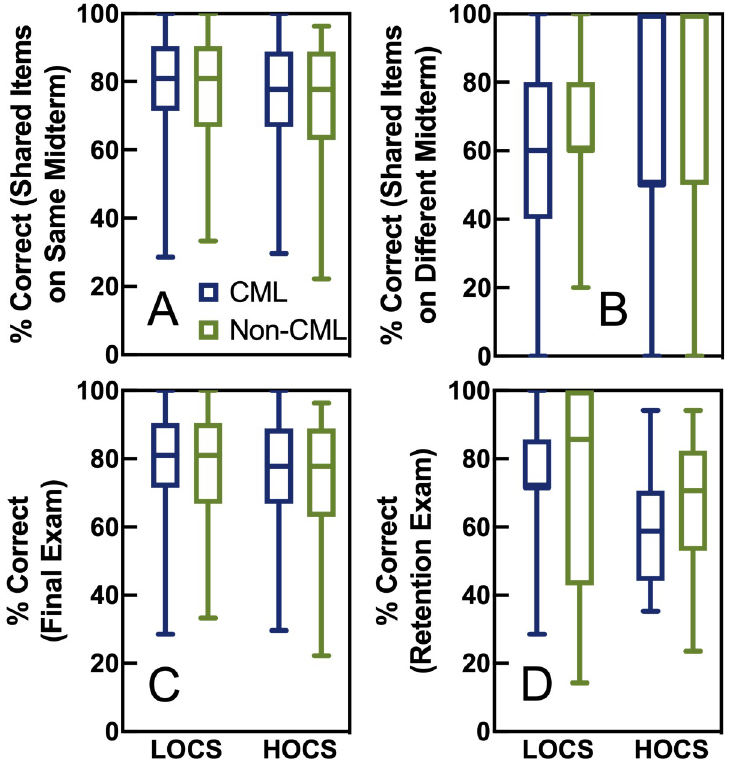
Fig 5. Effect of cumulative midterms by cognitive skill. All test items were categorized as requiring LOCS or HOCS and performance is shown by treatment (cumulative midterms = blue, non-cumulative midterms = green). The y axes show scores on shared midterm items that both sections saw the same day (Panel A, n = 344), shared midterm items that the cumulative section saw later (Panel B, n = 310), the final exam (Panel C, n = 344), and the retention exam (Panel D, n =